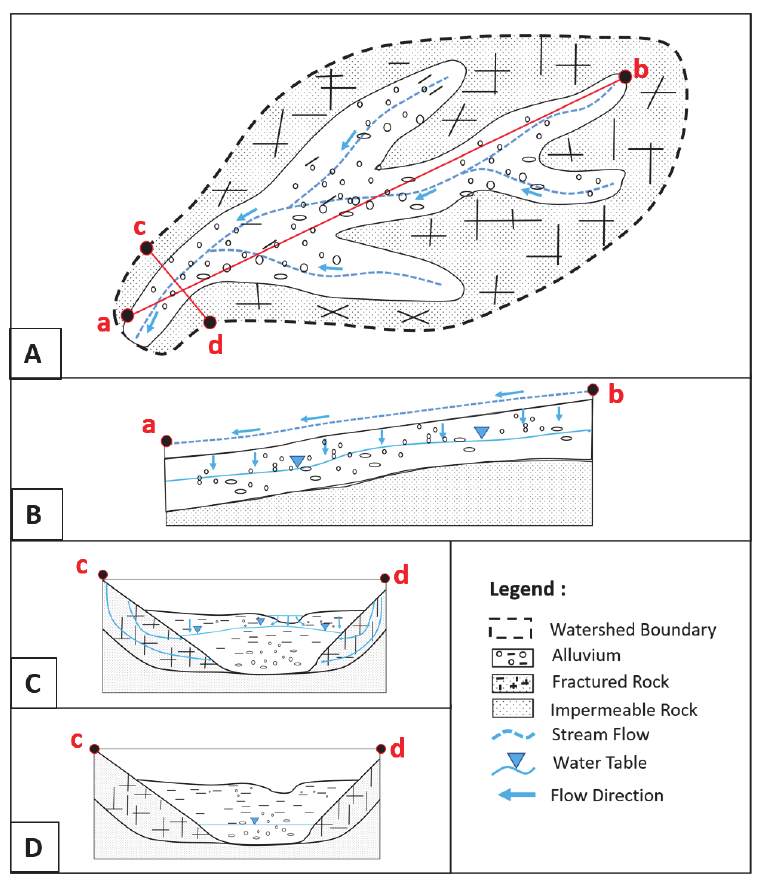
Figure 8. Conceptual model of the integrated surface and groundwater modeling: ( A ) The watershed contains alluvium and fractured rock on the surface; ( B ) Cross-section from a–b, where the water table elevation is getting higher to the upstream; ( C ) Cross-section from c–d, where during rainy season water table is high; ( D ) Cross-section from c–d, where during rainy season water table is low.